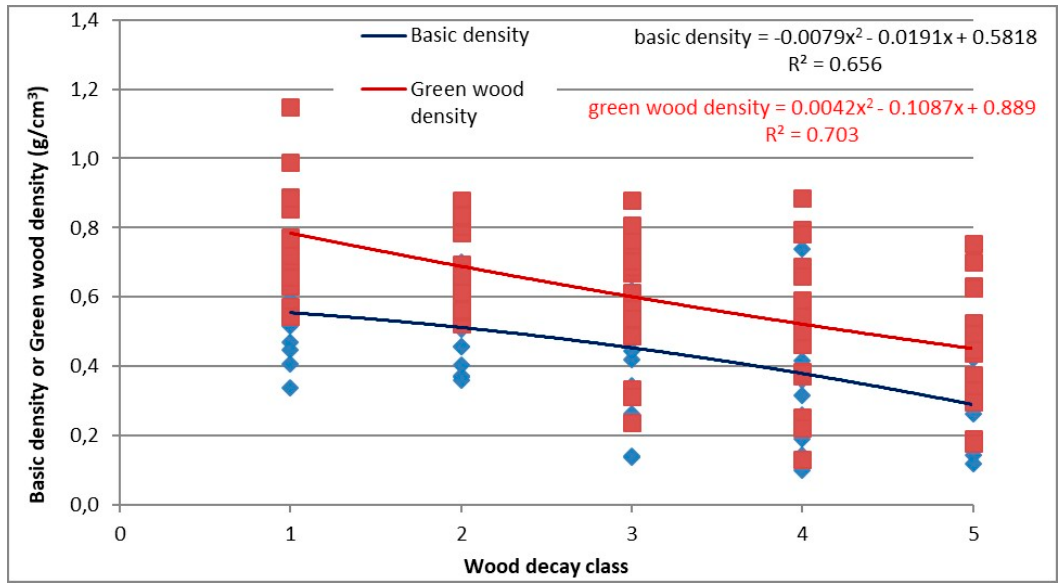
Figure 7. Polynomial curves describing the effect of the decay class on basic density and green wood density. Table 7. Average values for the main parameters of deadwood and carbon estimated distribution per decay classes (DC) in the pine type.